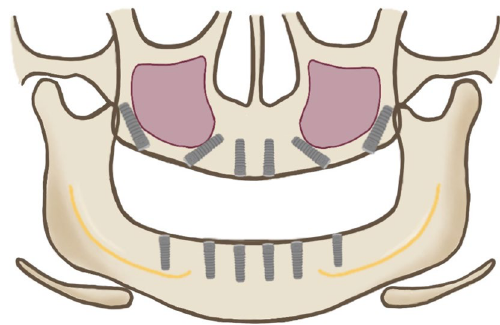
Fig. 6 A schematic of the placement of implant extruding the cortical bone of the anterior wall of the maxillary